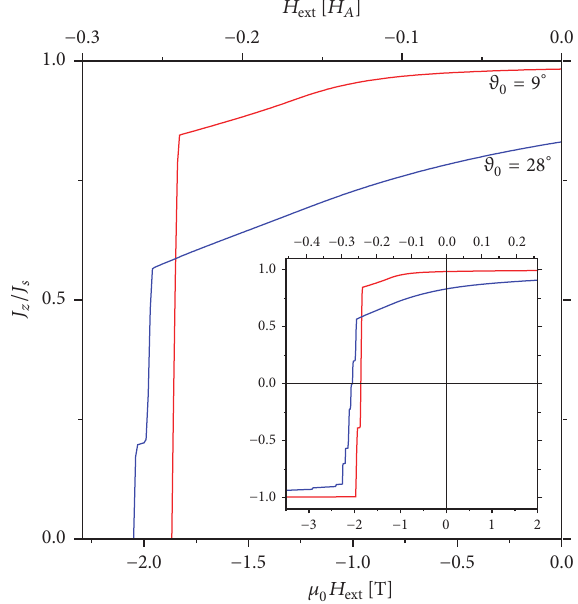
Figure 12: Simulated hysteresis curves of the 27-G-GBj model structure with a distribution of the misorientation angle 𝜗 0 of the hard magnetic grains with an average of 9 ∘ and 28 ∘ , respectively. The simulation with the greater misorientation has a higher 𝐻 𝑐𝐽 (by